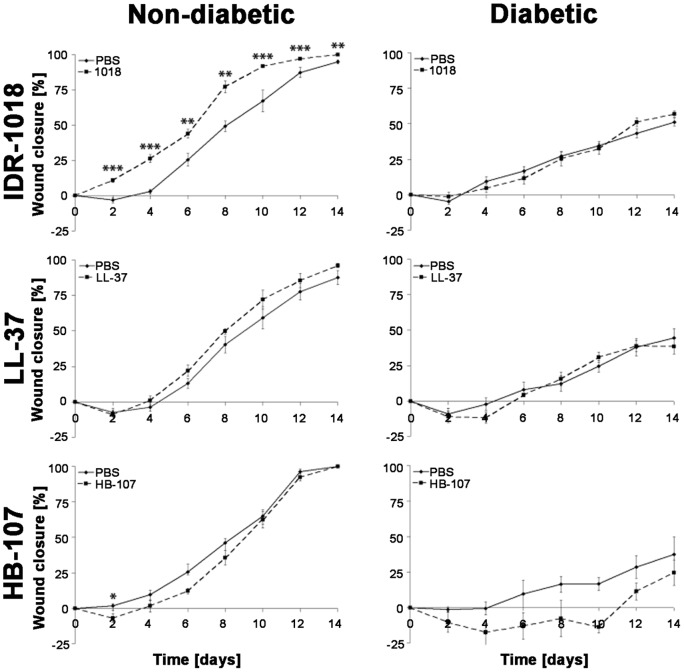
Efficacy in murine wound healing of IDR-1018 compared to LL-37 and HB-107.On day 0, mice were wounded on two dorsolateral areas. Treatments were administered every 48 hours for 14 days with either 15 µl of vehicle control (PBS; wound one) or 200 µg/ml (3 µg/dose) of the indicated peptides (wound two). Re-epithelialization was measured every second day. The bars represent standard error of the mean wound closure (*  = p<0.05; **  = p<0.01; ***  = p<0.005 compared to vehicle control).